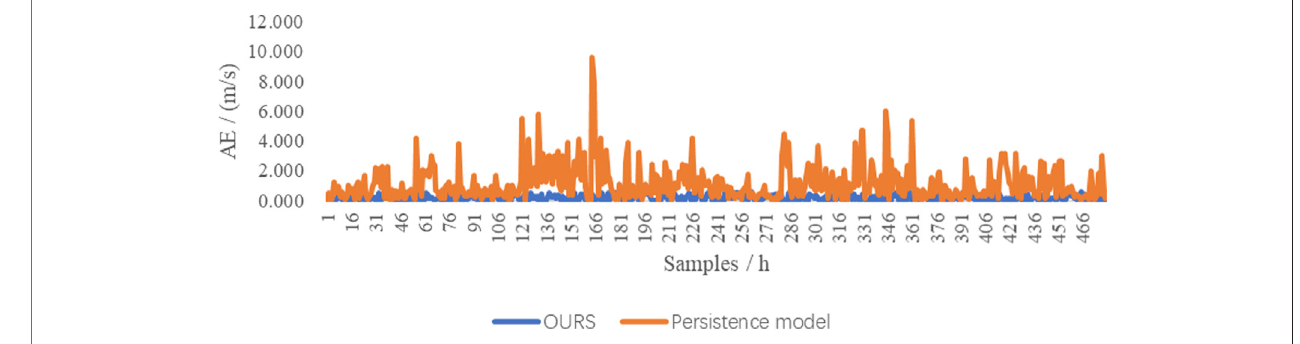
FIGURE 10 | Comparison of the persistence method and ours.